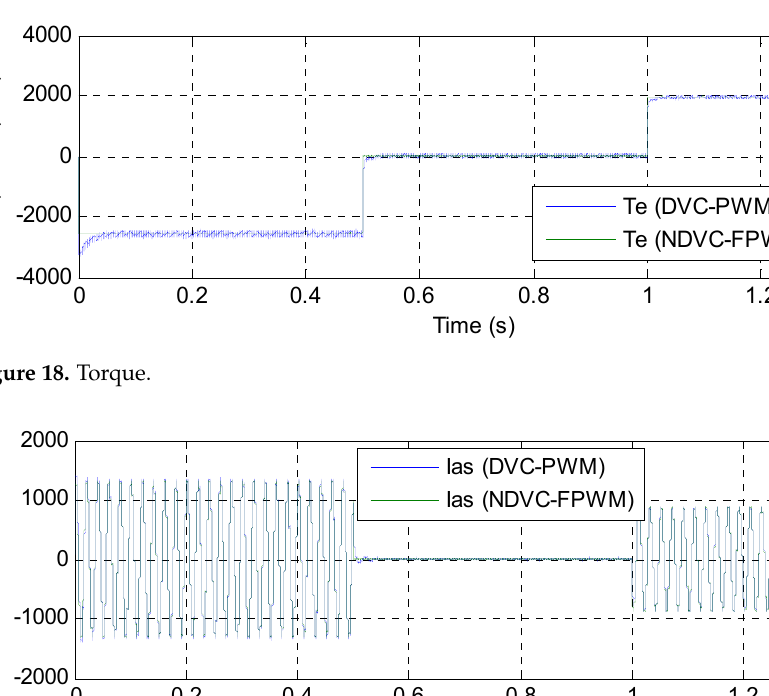
Figure 17. Reactive power.